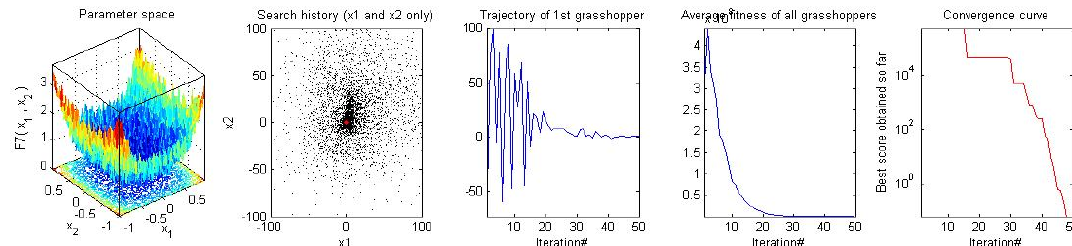
Figure 8. HAGOA search behavior on unimodal function (F7)